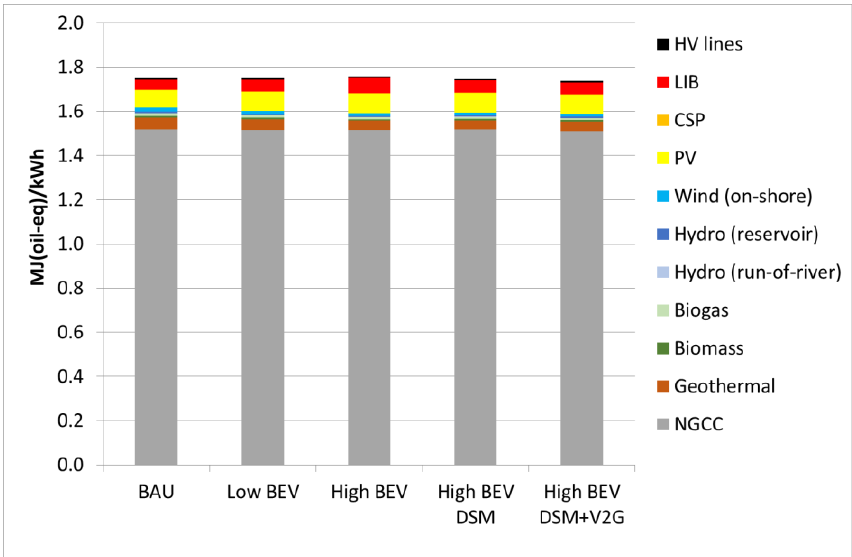
Figure 7. Non-renewable cumulative energy demand (nr-CED) of 1kWh of electricity supplied by the domestic grid, with contributions by technology.